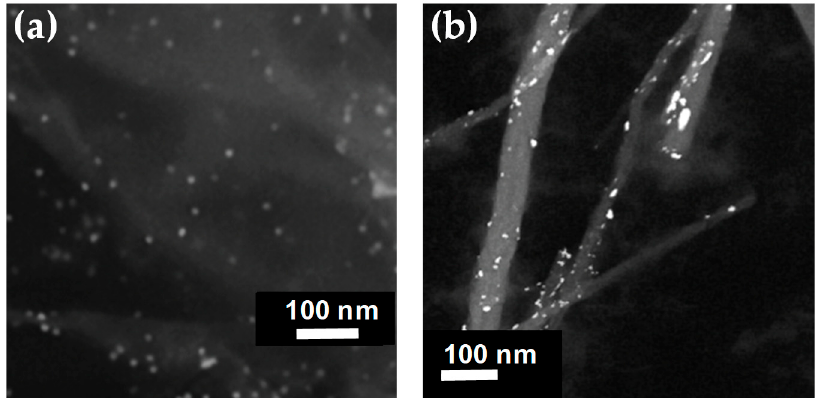
Figure 2. Transmission electron microscopy (TEM) micrographs of: ( a ) PtPd/rGO; and ( b ) PtPd/MWCNT.